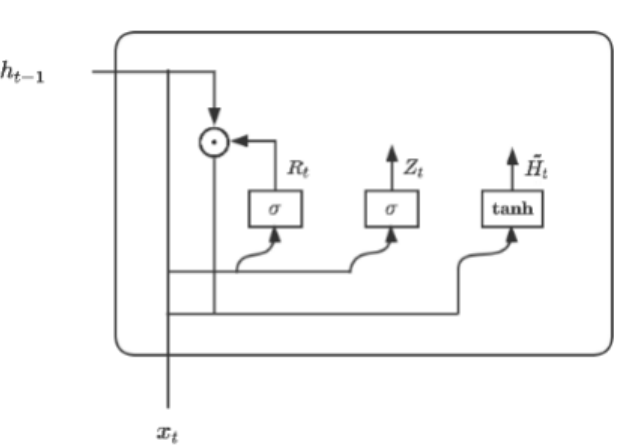
Figure 3. Structure of candidate hidden